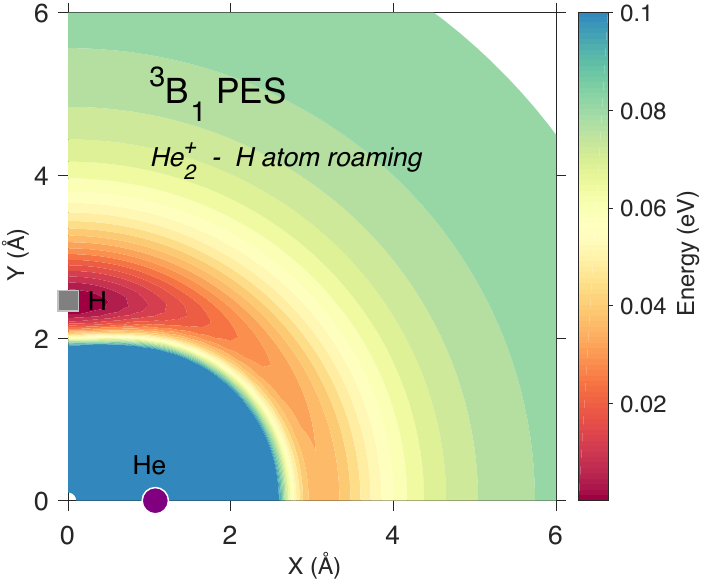
Figure 1. The two-dimensional triplet He 2 H + PES in eV for the motion of the hydrogen atom (gray square) around the fixed positions of the helium atoms (purple circles) in the 2 Σ u He 2 + molecule with one shown on the x-axis. The minimum corresponds to the geometry of the 3 B 1 state, 10.90 eV above the minimum of the ground 1 Σ + g state.